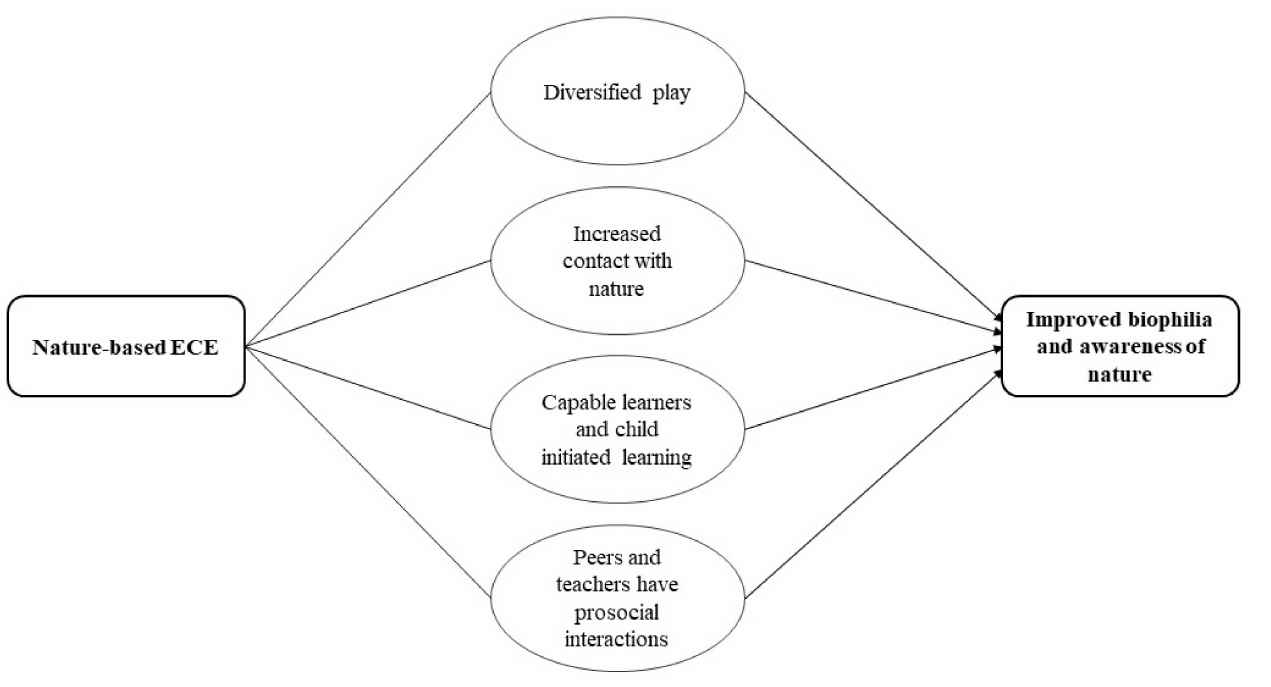
Figure 10. Convergent synthesis on how nature-based ECE could influence biophilia and awareness of nature. An arrow denotes where factors lead to an influence on biophilia and awareness of